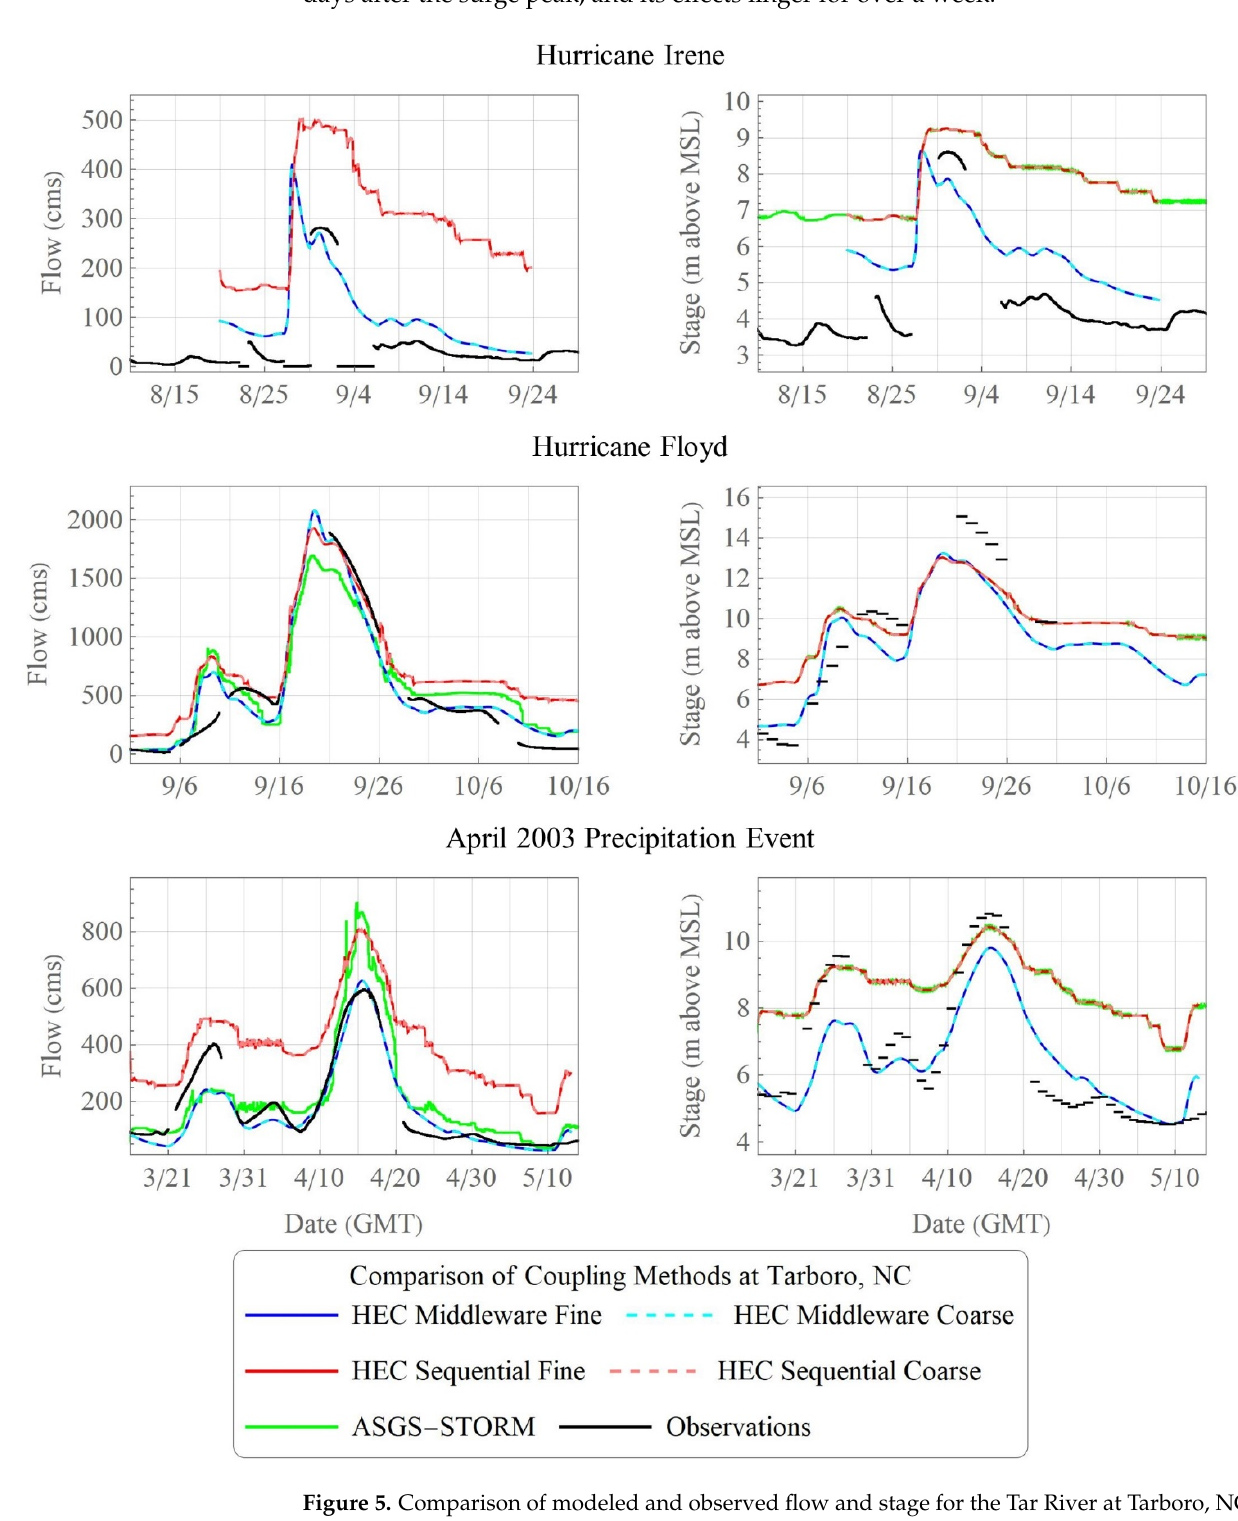
Figure 5. Comparison of modeled and observed flow and stage for the Tar River at Tarboro, NC.